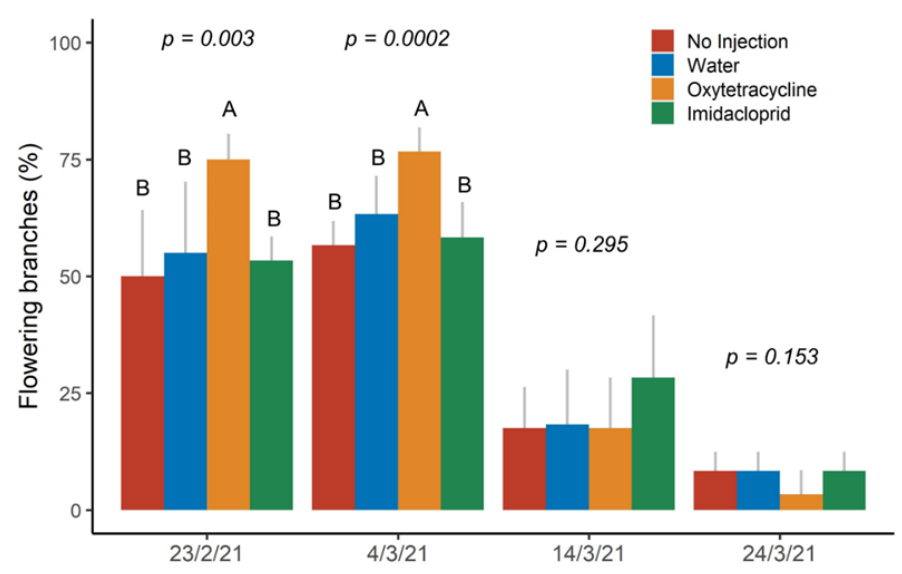
Figure 6. Percent of branches with flowers in spring 2021 after injection in October 2020. Different letters within each time point indicate significant differences ( p < 0.05) among treatments according to Tukey’s honest significant difference test. Letters not shown when differences were not significant.